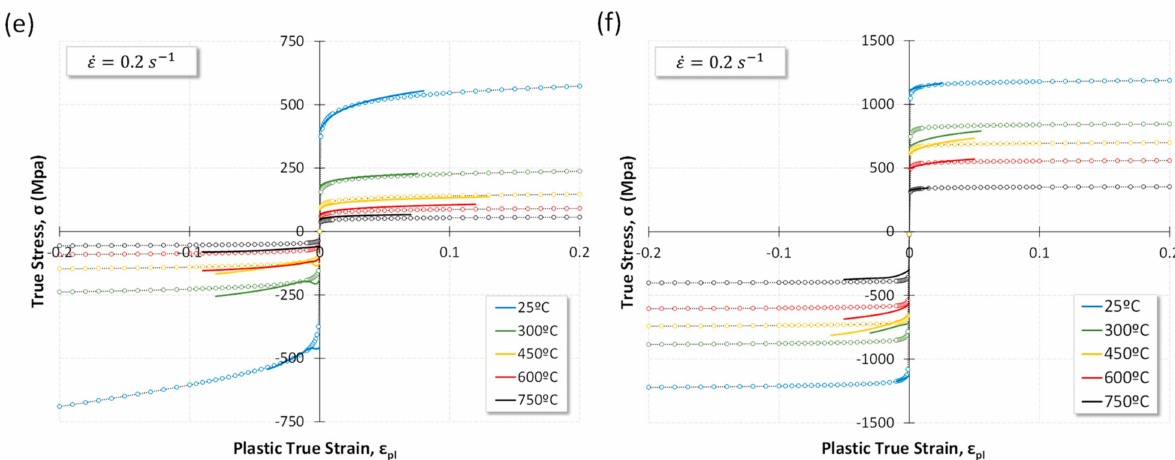
Figure 20. Experimental (continuous trace) and modeling (dotted line) T-C functions for Ticp2 ( a , c , e ), and Ti6Al4V ( b , d , f ); the results correspond to TD (90 ◦